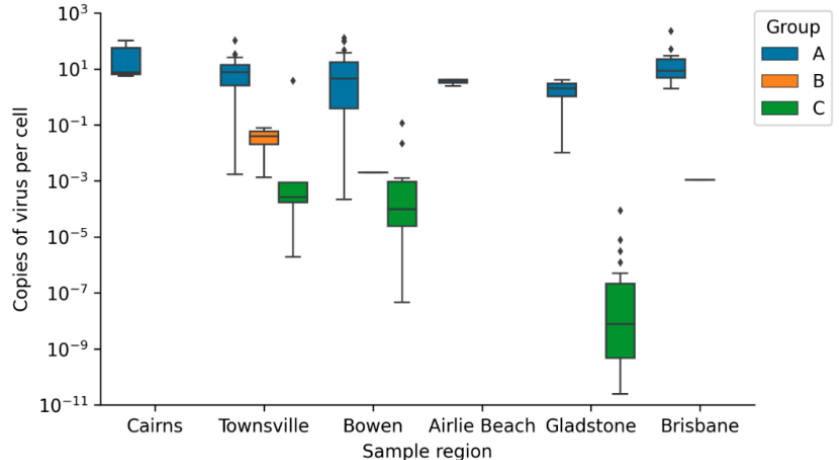
Figure 2. Boxplots of ChHV5 viral loads (log scale) in different sample types from six regions of Queensland. Group A (FP Tumours), Group B (Non-tumoured skin from turtles with FP tumours) and Group C (Skin from non-tumoured turtles). The Box plots of viral loads include the median (centre horizontal line), interquartile range (box), minimum and maximum (whiskers), and outliers (diamonds).